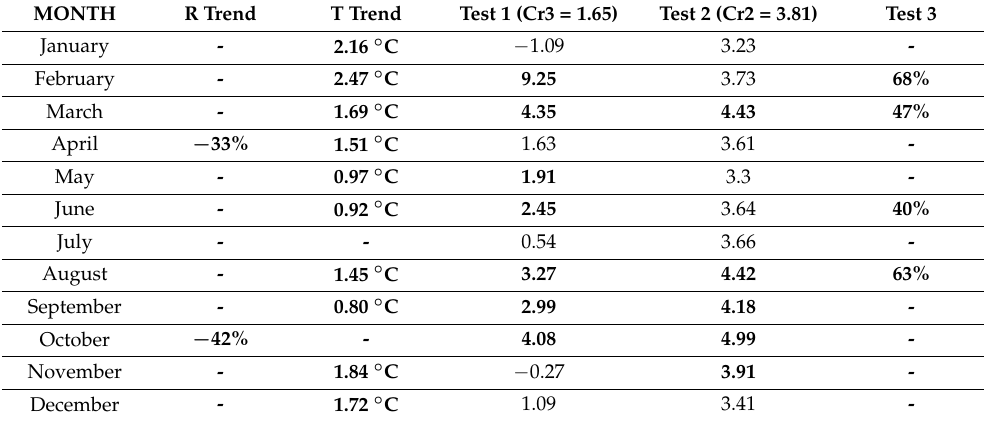
Table 1. Examination of monthly precipitation sum (R) and mean temperature (T) values. Meaning of the symbol: no significant change (significance level = 0.1). R trend shows the significant precipitation change over the total period (1871–2020), T trend shows the significant temperature change over the total period (1871–2020), Tests 1–3 show the results of statistical tests; statistics above the critical value are shown in bold. R Trend T Trend Test 1 (Cr3 = 1.65) Test 2 (Cr2 =